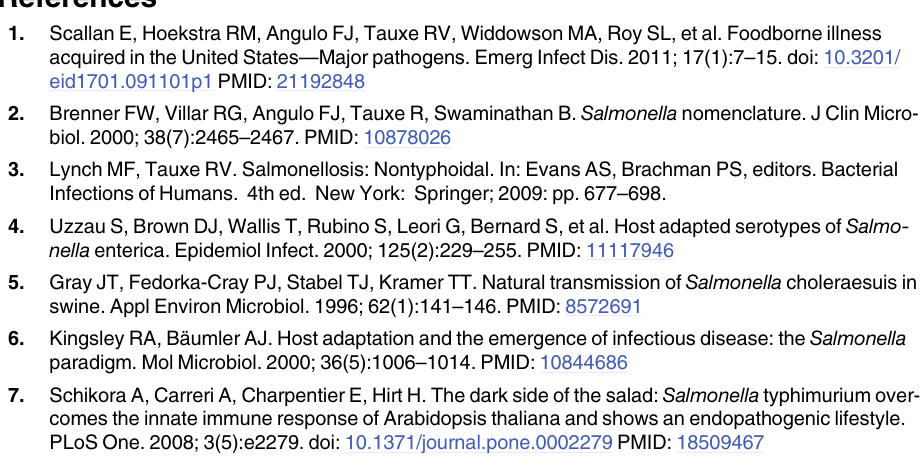
S1 Table. Coefficient of Variance for Salmonella Serotypes Reported at Least 1,600 Times During 1996 – 2011 to CDC, by State, Month of Year, Age Group, and Sex, with Illustrative Figures (listed from most to least